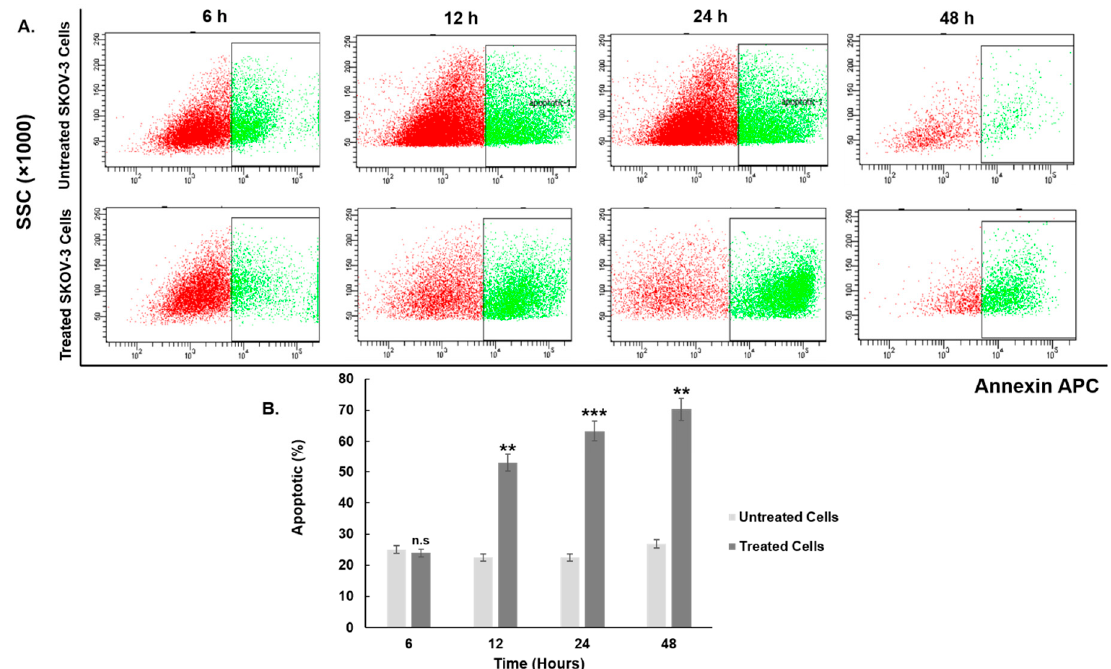
Figure 6. Effect of curcuminoids on SKOV-3 cell apoptosis. ( A ) Flow cytometry analysis of apoptosis in SKOV-3 cells either untreated or treated with 30 µM of curcuminoids for various time periods. After the treatment periods, the cells were stained with Annexin APC and subsequently analyzed by flow cytometry. ( B ) The percentage of apoptotic cells in response to curcuminoids. ** and *** indicate statistical significance (p < 0.01 and p < 0.001, respectively), compared to the untreated cells.